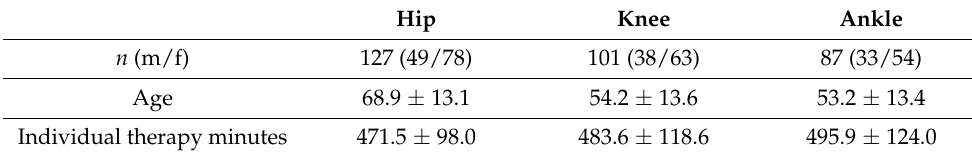
Table 1. Demographic data for subjects in all three